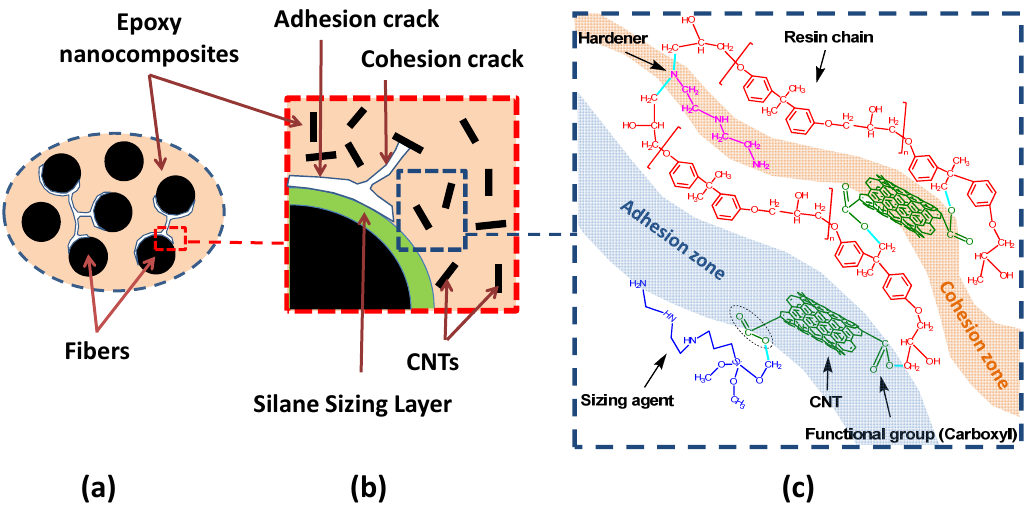
Figure 7. Hypothesized schematic for chemical reaction between COOH functionalized MWCNTs and epoxy that improves bond between glass fibers and epoxy incorporating COOH functionalized MWCNTS. ( a ) Typical inter fiber fracture; ( b ) adhesion/bond cracks and cohesion/shear cracks are limited with the addition of Carbon Nanotubes (CNTs); and ( c ) potential chemical reactions that improve adhesion/bond strength and cohesive/shear strength of the fiber/matrix interface and epoxy matrix respectively.